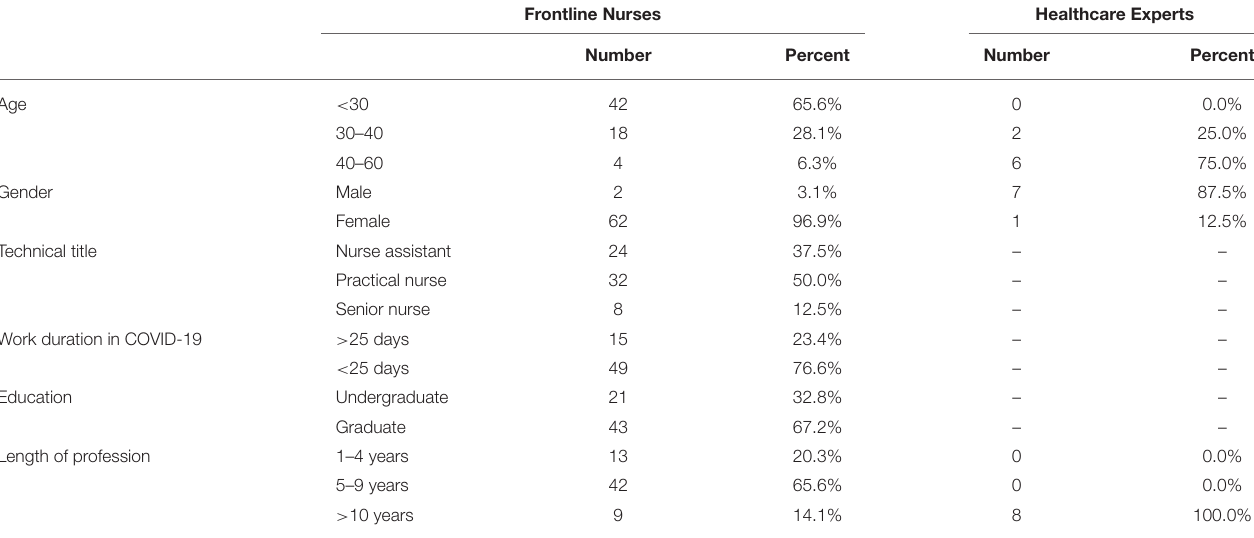
TABLE 1 | Characteristics of the